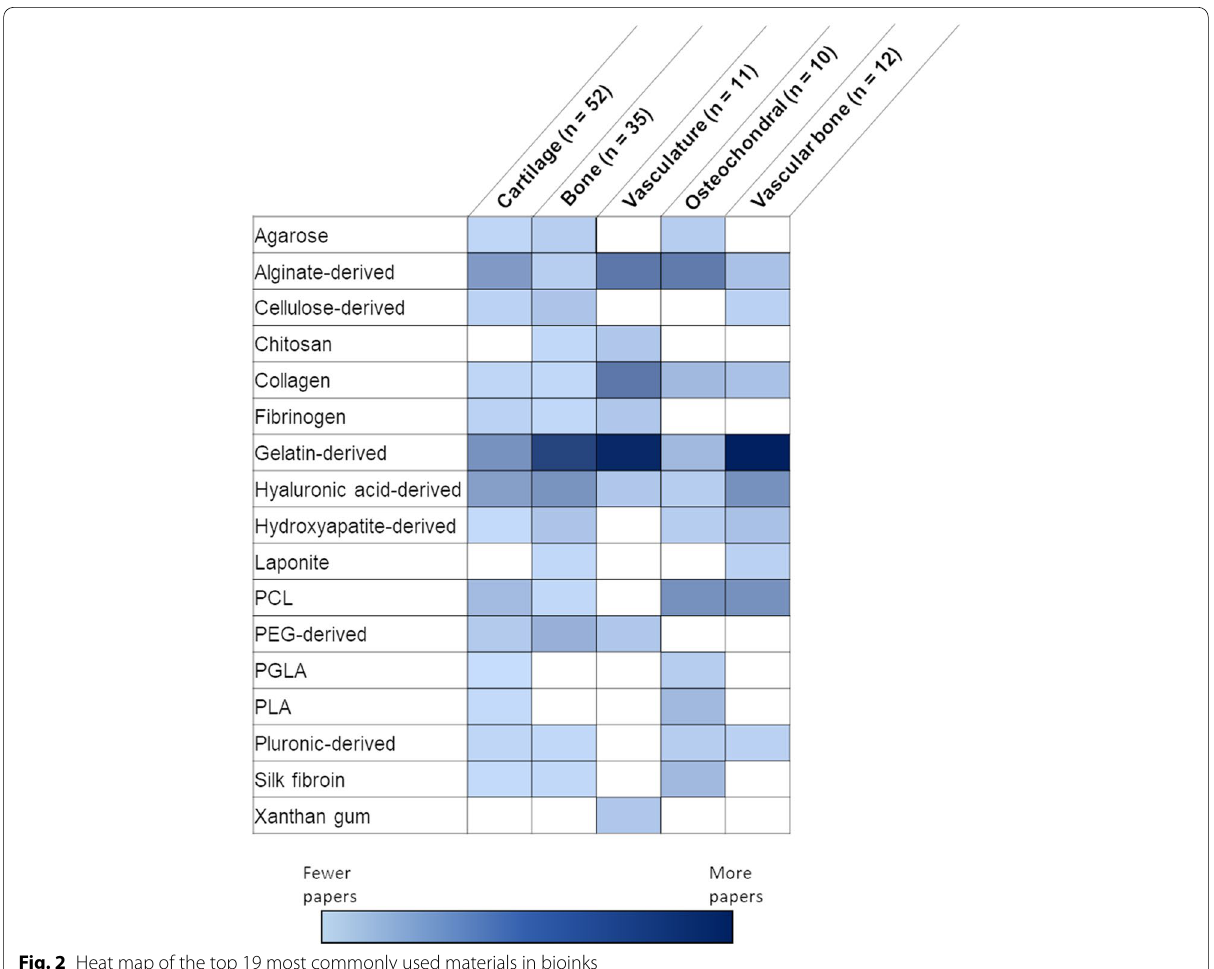
Fig. 2 Heat map of the top 19 most commonly used materials in bioinks PCL: poly (caprolactone), PEG: poly(ethylene glycol), PGLA: poly(lactic‑co‑glycolic acid), PLA: poly (lactic acid). White indicates not